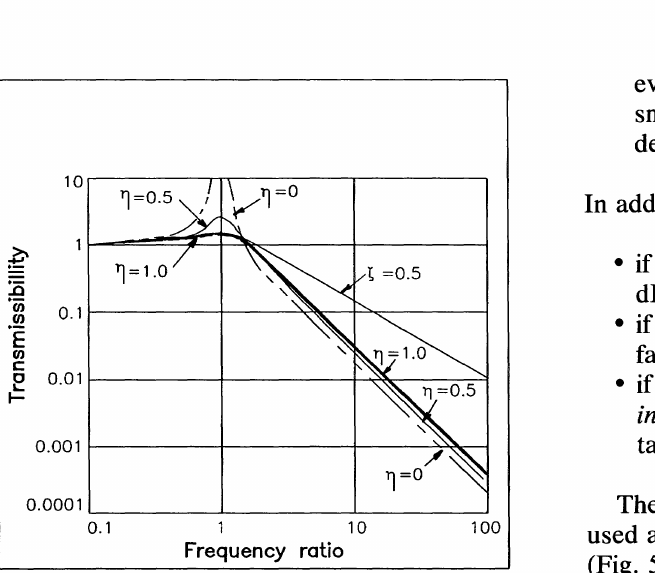
FIGURE 3 Transmissibility of single degree-of-free dom system with viscous damping (~) or hysteretic damping (1) vs. frequency ratio (forcing frequency, 01 natural frequency, w).